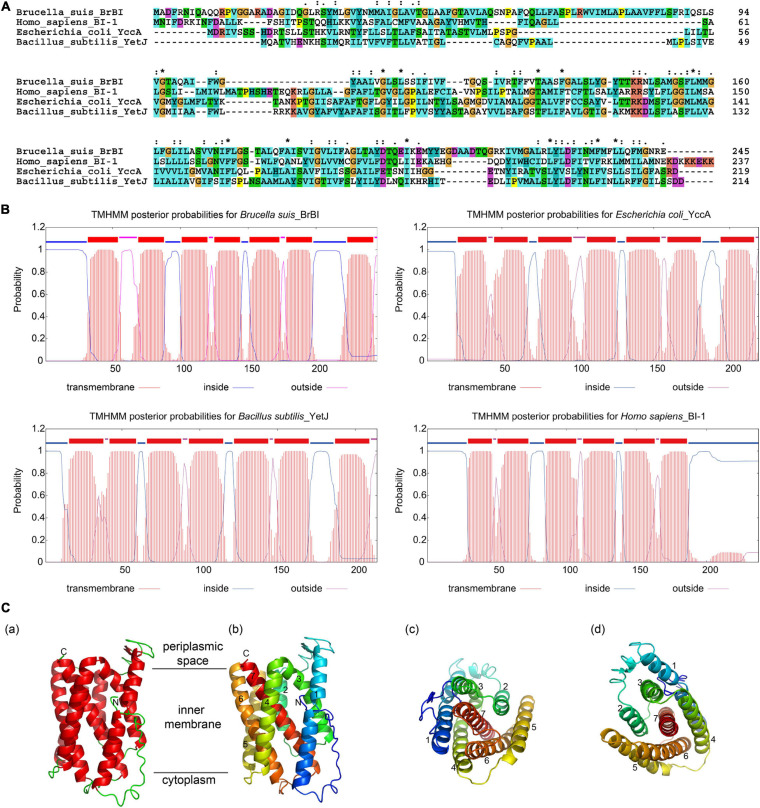
Bioinformatic analysis of BrBI. (A) Multiple amino acid sequence alignment of BI-1 family proteins. Orange indicates residue G; yellow indicates residue P; green indicates residues T, S, N, and Q; blue indicates residues W, L, V, I, M, A, F, and C; cyan indicates residues H and Y; magenta indicates residues E and D; red indicates residues K and R; “*” indicates fully conserved residues; “:” indicates strongly conserved residues; “.”indicates weakly conserved residues. (B) Prediction of BI-1 family protein transmembrane helices. The protein transmembrane helices were predicted using the TMHMM Server. (C) Predictive 3D structure of BrBI by I-TSAAER. (a) Red ribbons indicate transmembrane helices; green lines indicate loop structures; N indicates the N-terminus of BrBI; C indicates the C-terminus of BrBI. (b) Colored ribbons with numbers indicate 7 transmembrane helices of BrBI. (c,d) View of BrBI from the cytoplasm (c) and periplasmic space (d). Colored ribbons with numbers indicate 7 transmembrane helices of BrBI. For (b–d), the ribbon was colored using the rainbow color scheme implemented in PyMOL.